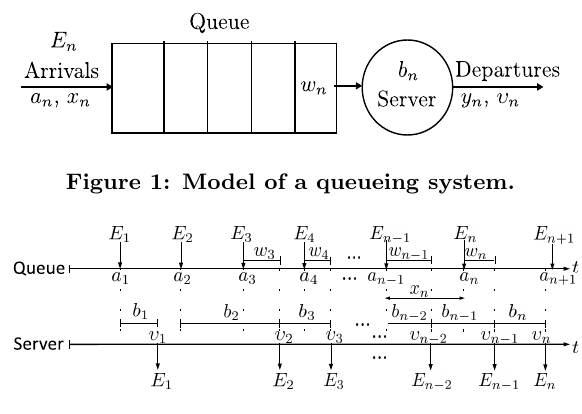
Figure 2: Time diagram for an infinite queueing sys- tem.